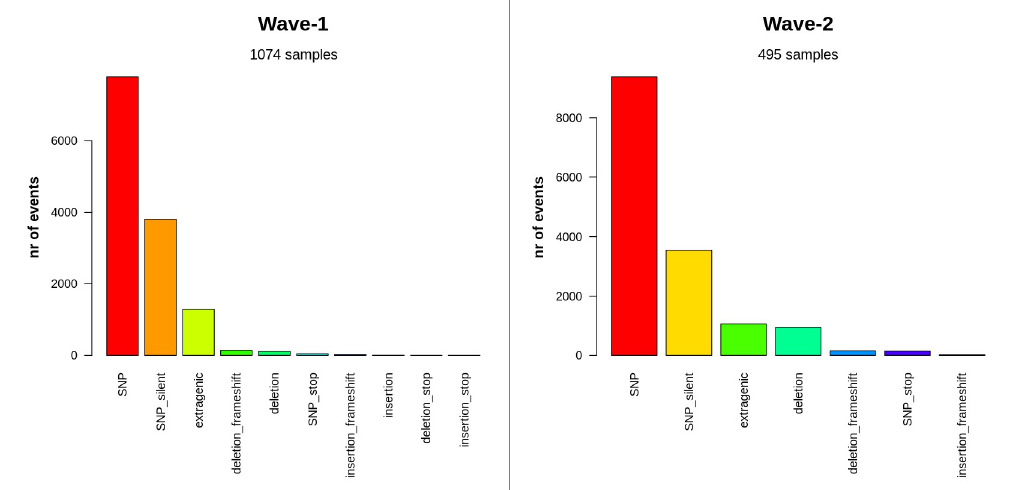
Fig 3. Distribution of mutation classes between two waves of COVID-19 in Bangladesh. SNPs, silent SNPs, and extragenic mutations were similarly abundant in both waves. But, sequences of wave-2 had a significant amount of deletion events.